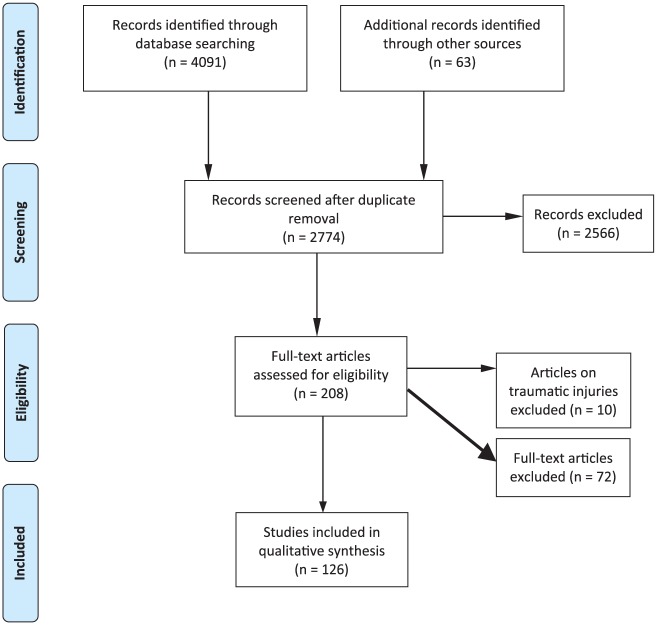
Flow diagram (from PRISME).Source.
Moher, Liberati, Tetzlaff, and Altman (2009).